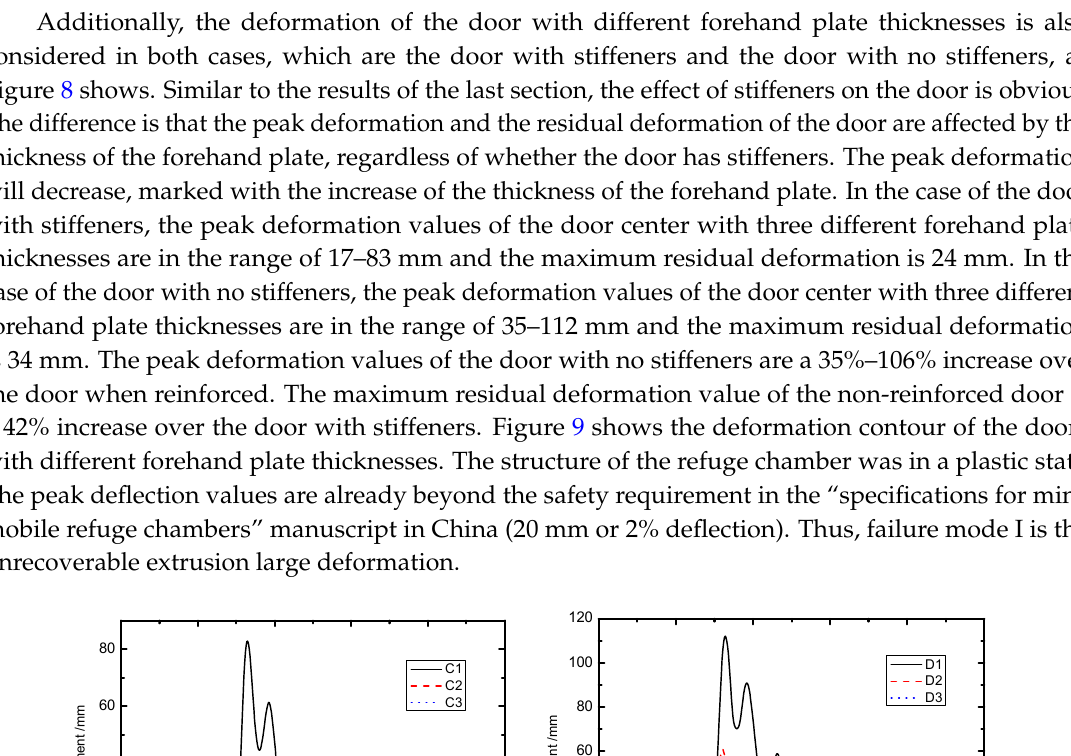
Figure 7. Maximum deformation of the door with different thicknesses. ( a ) A1; ( b ) A2; ( c ) A3; ( d ) B1; ( e ) B2 and ( f ) B3.